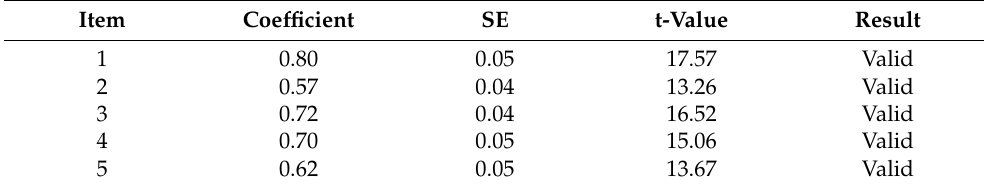
Table 1. Validity of religiosity